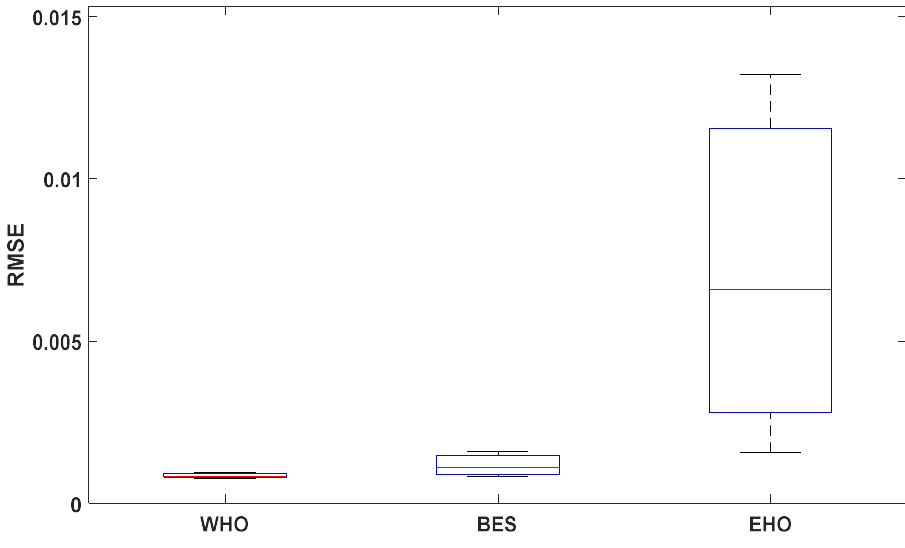
Figure 11. Boxplot of all algorithms for 30 independent runs applied to MDDM.